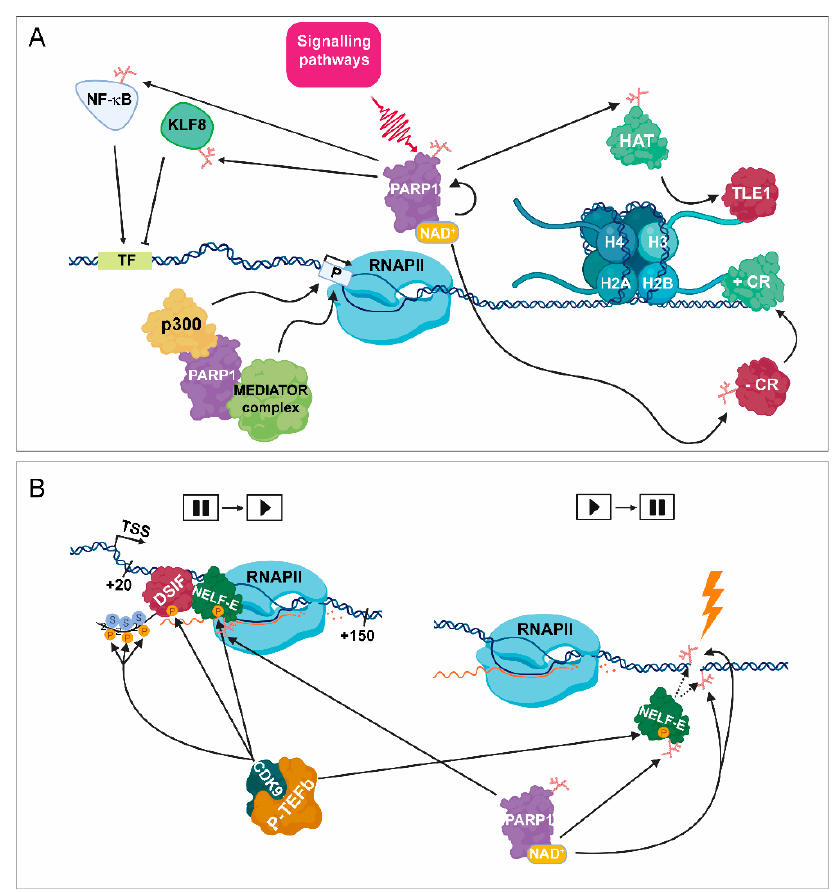
Figure 1. PARylation in transcription initiation. ( A ) As a consequence of the activation of certain signalling pathways, PARP1 catalyses the transfer of ADP-ribose through its binding to NAD + cofactor. PARP1 can PARylate numerous sequence-specific transcription factors, such as NF- κ B and KLF8, which can facilitate and attenuate transcription initiation, respectively. PARP1 can also act as a scaffold protein by promoting the recruitment of various co-regulator complexes, such as p300 and the mediator complex to the promoter region (P), leading to transcription initiation catalysed by RNAPII. Moreover, PARP1 is implicated in the release of subsequent corepressor complex, such as transducin-like enhancer protein 1 (TLE1), resulting in its exchange to the PARylated HAT complex. PARP1 also participates in the exchange between negative coregulators, (–CRs) to positive ones (+ CRs). TF = transcription factor binding site. ( B ) (Left part) Following transcription initiation, RNAPII is stopped at around +20–+150 bp from the TSS. The promoter-proximal pausing process is induced by negative elongation factors, such as NELF-E and DSIF. During the release of the initial pausing, CDK9/ PTEFb phosphorylates NELF-E, DSIF, and the CTD of RPB1 (the largest subunit of RNAPII) at Ser2. Phosphorylated NELF-E (P-NELF-E) is released from RNAPII, while phosphorylated DSIF (P-DSIF) acts as a positive elongation factor, and the S2P-RNAPII becomes capable of proceeding the elongation step. Right part: Following DNA damage, PARP1 targets P-NELF-E for PARylation, thereby hindering its DNA-binding ability, leading to transcription